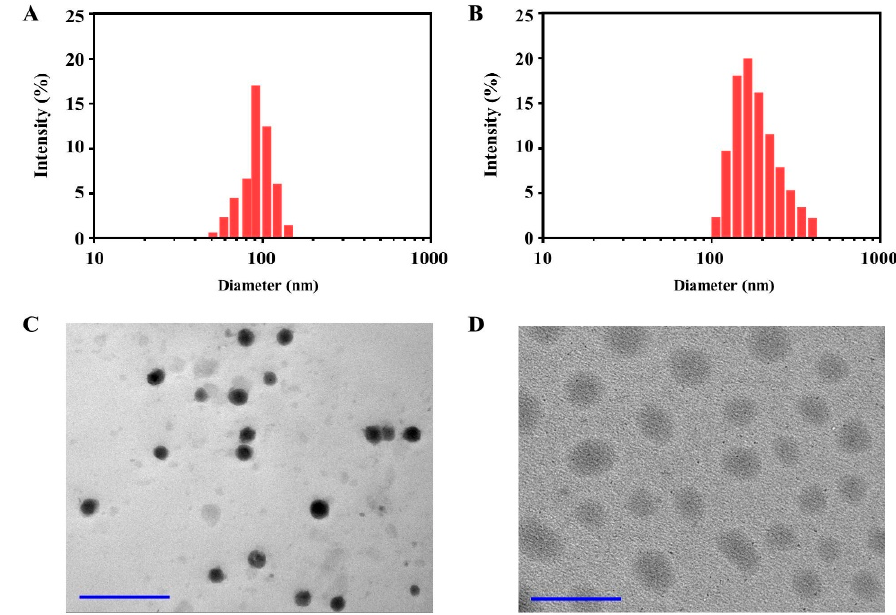
Figure 2. Characterization of oDex-g-Pt NPs (platinum conjugated oxidized dextran nanoparticles) and oDex-g-Pt+DOX NPs (platinum plus DOX conjugated oxidized dextran nanoparticles). Particle size and size distributions of oDex-g-Pt NPs ( A ) and oDex-g-Pt+DOX NPs ( B ) in Milli-Q water. TEM images of the oDex-g-Pt NPs ( C ) and oDex-g-Pt+DOX NPs ( D ) (Scale bars: 500 nm).